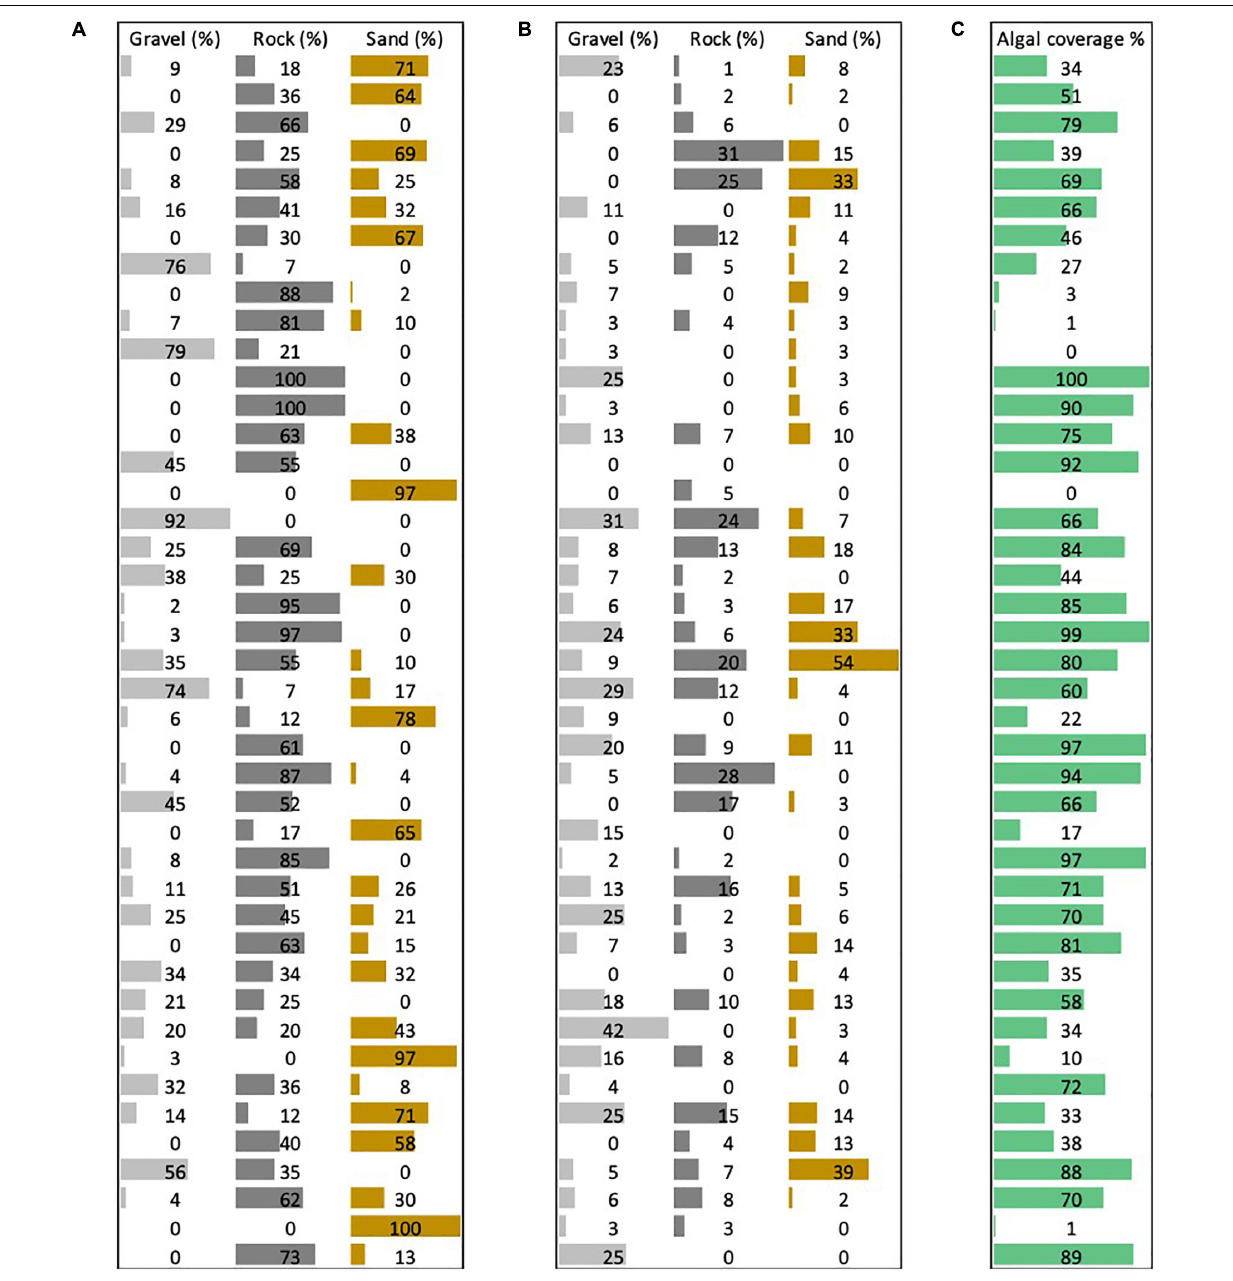
FIGURE 3 | Percentage average of (A) primary benthos type composition by transect. Percentage average of (B) secondary benthos type composition by transect. (C) Percentage of algal